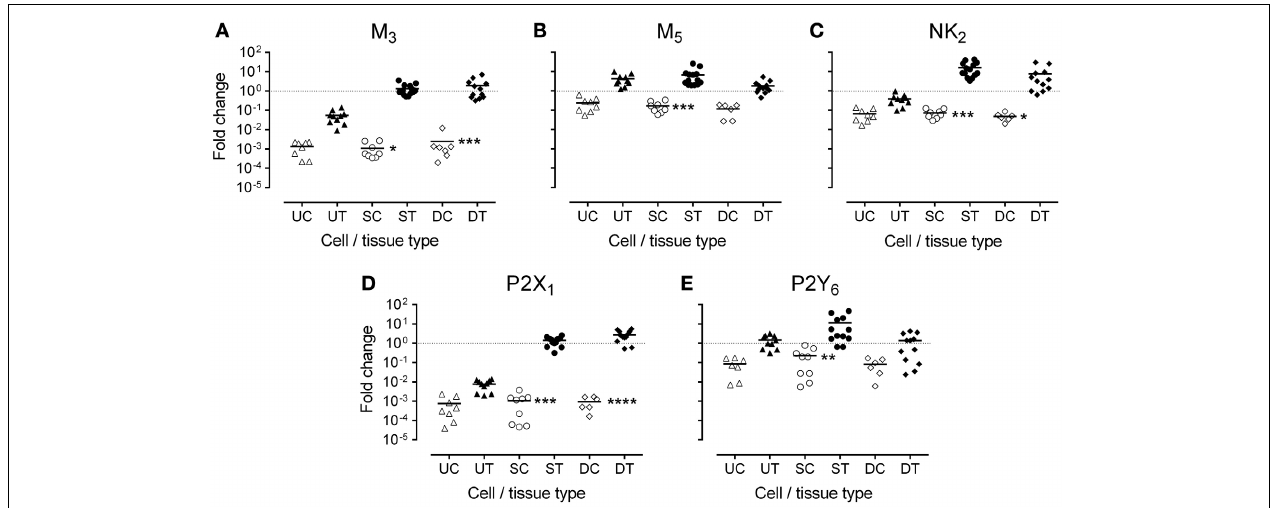
FIGURE 3 | Expression of mRNA for (A) muscarinic (M 3 ), (B) muscarinic (M 5 ), (C) tachykinin (NK 2 ), (D) purinergic (P2X 1 ), and (E) purinergic